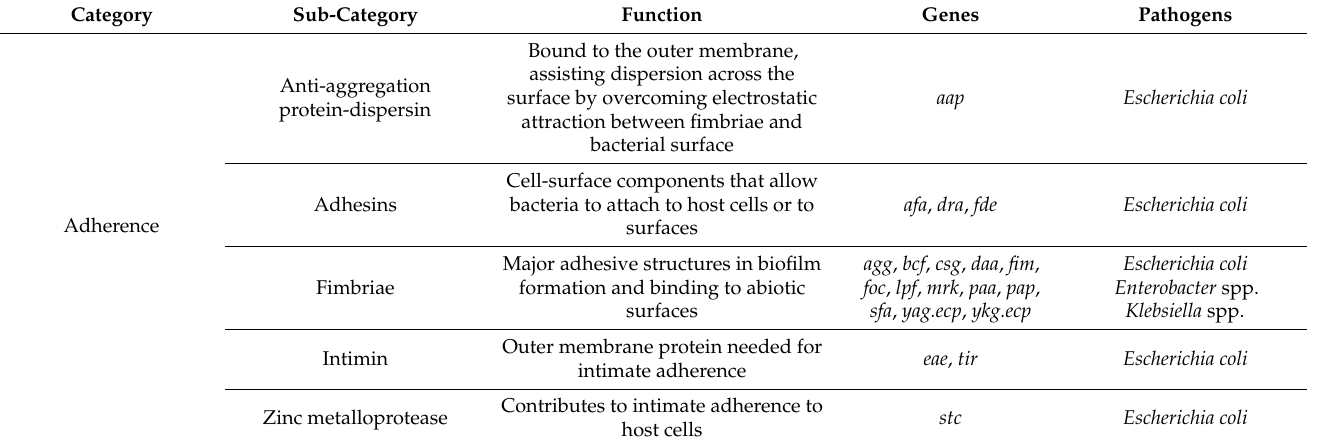
Table 1. Main virulence factors in